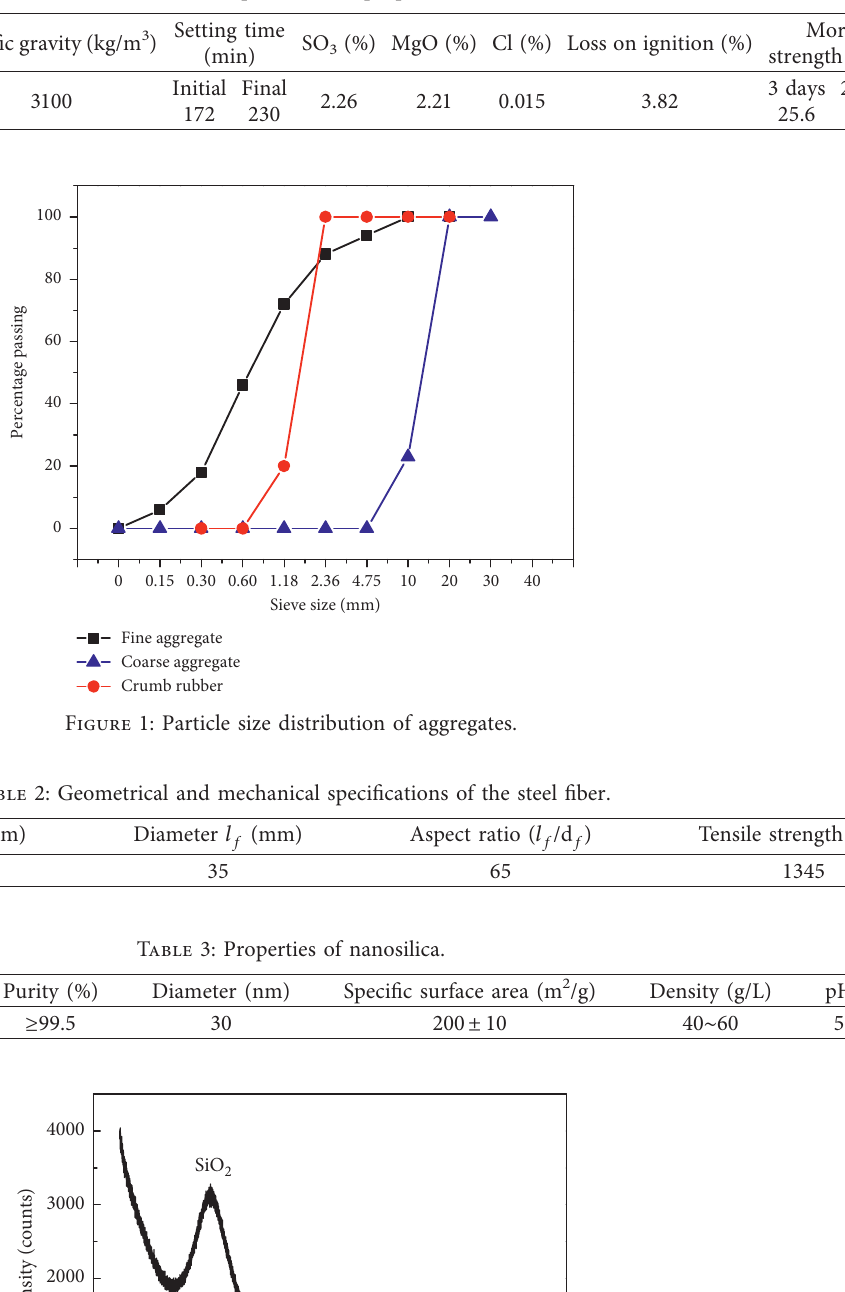
Table 1: Chemical composition and properties of cement.